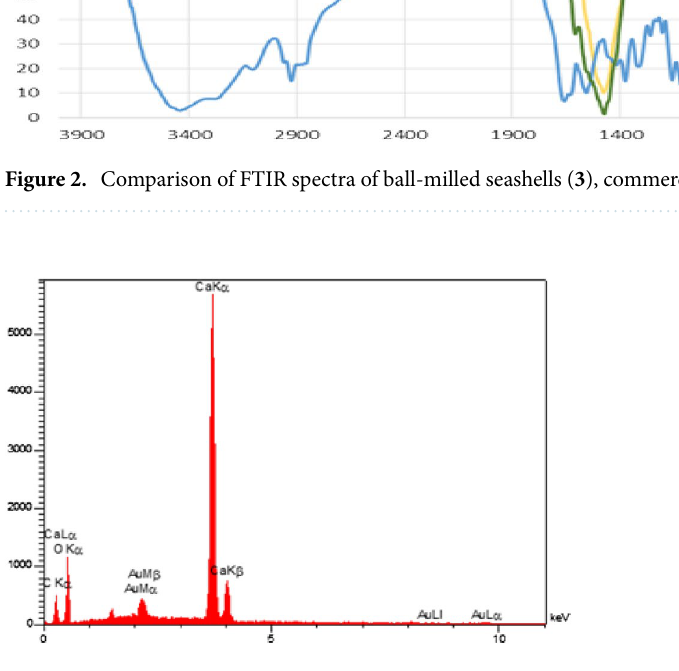
Figure 3. Energy-dispersive X-ray (EDX) analysis of the ball-milled seashells nano-biocomposite ( 3